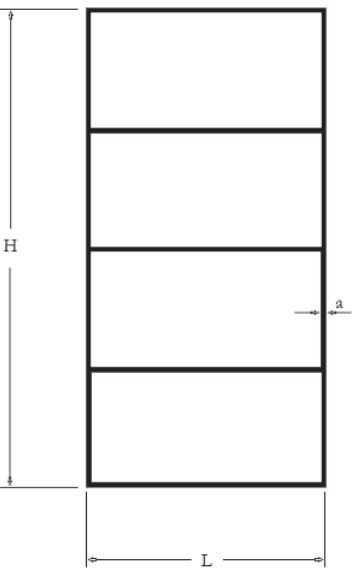
Modelo estrutural com suas principais medidas do pórtico utilizado para estudo de análise modal